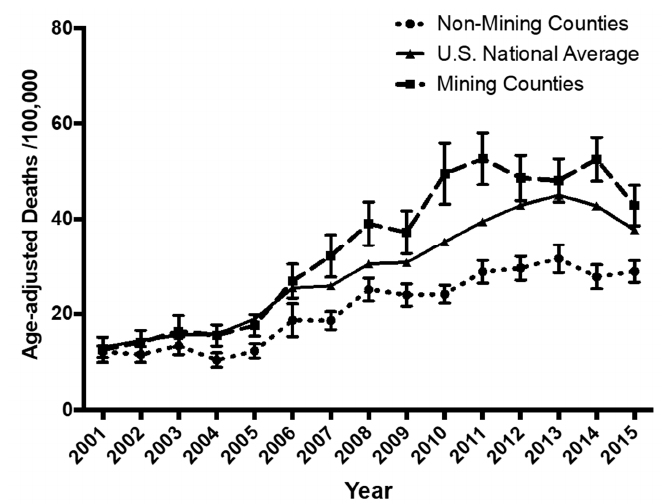
Figure 8. Comparison of vascular and unspecified dementia mortalities for West Virginia MTM and non-mining counties with the United States’ national average. These data suggest that while the rates for all three populations are initially the same, the data diverge around 2007. After 2007, WV MTM counties exhibited more steeply increasing rates of dementia mortality, than did non-mining West Virginia counties or the U.S. on average. Comparison of post-2007 data for non-MTM WV counties with that for the U.S. as a whole suggests that living in the former may actually confer a degree of protection relative to the county as a whole. This remains to be explored. National average data (means and Standard Errors of the Mean (S.E.M.s) only) were downloaded from the Center for Disease Control Wonder website, https://wonder.cdc.gov/, and the error bars are within the scale of the symbol. Int. J. Environ. Res. Public Health 2019 , 16 , x